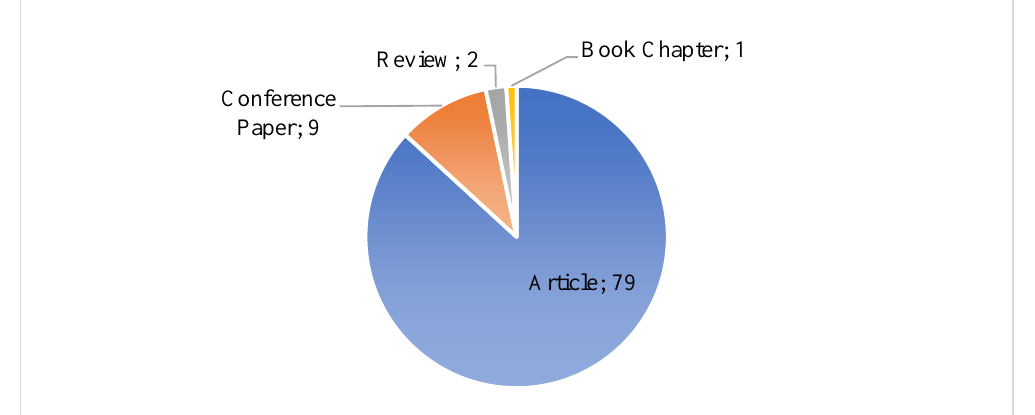
Fig. 7. Documents by type.